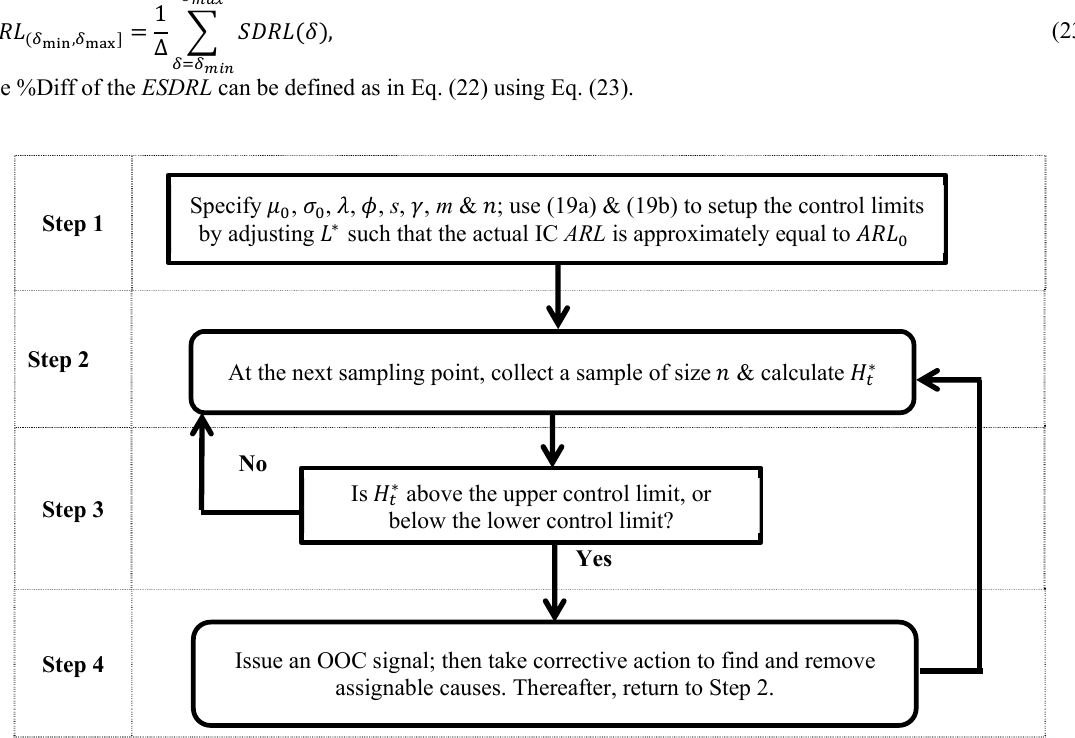
Fig. 1. Flow chart illustrating the operational procedure of the HWMA 𝑋(cid:3364) ∗ scheme using mixed- 𝑠 & 𝑚 strategy 4.2 Sensitivity of the HWMA 𝑋(cid:3364) ∗ scheme with constant